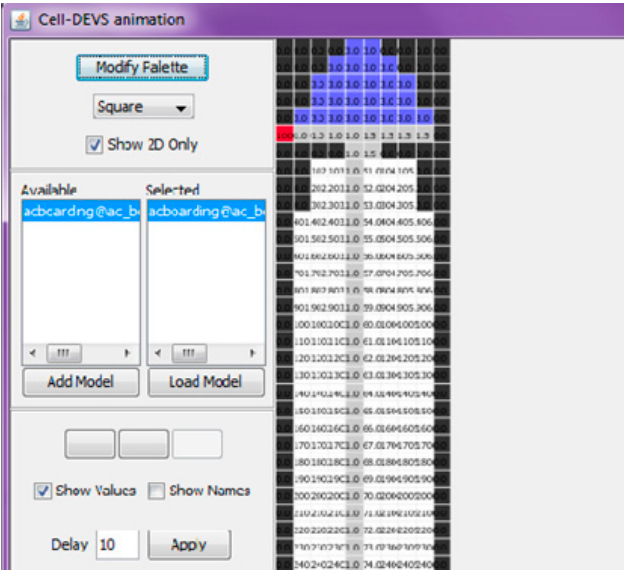
Figure 21. CD++ animation for Cell-DEVS.